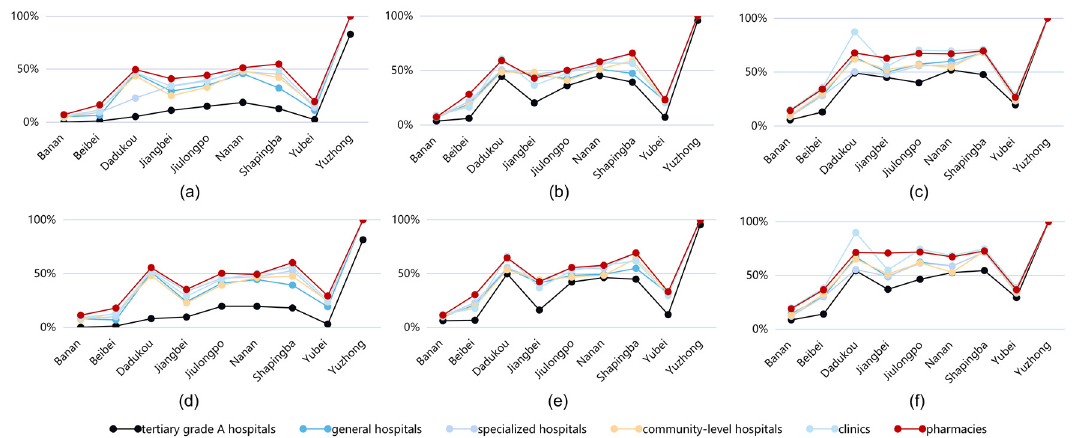
Figure 5. The average service population ratio and average service area ratio under different travel times of various medical facilities: ( a – c ) average service area ratio for 15 min, 30 min, and 60 min travel time; ( d – f ) average population ratio served at 15 min, 30 min, and 60 min travel time.